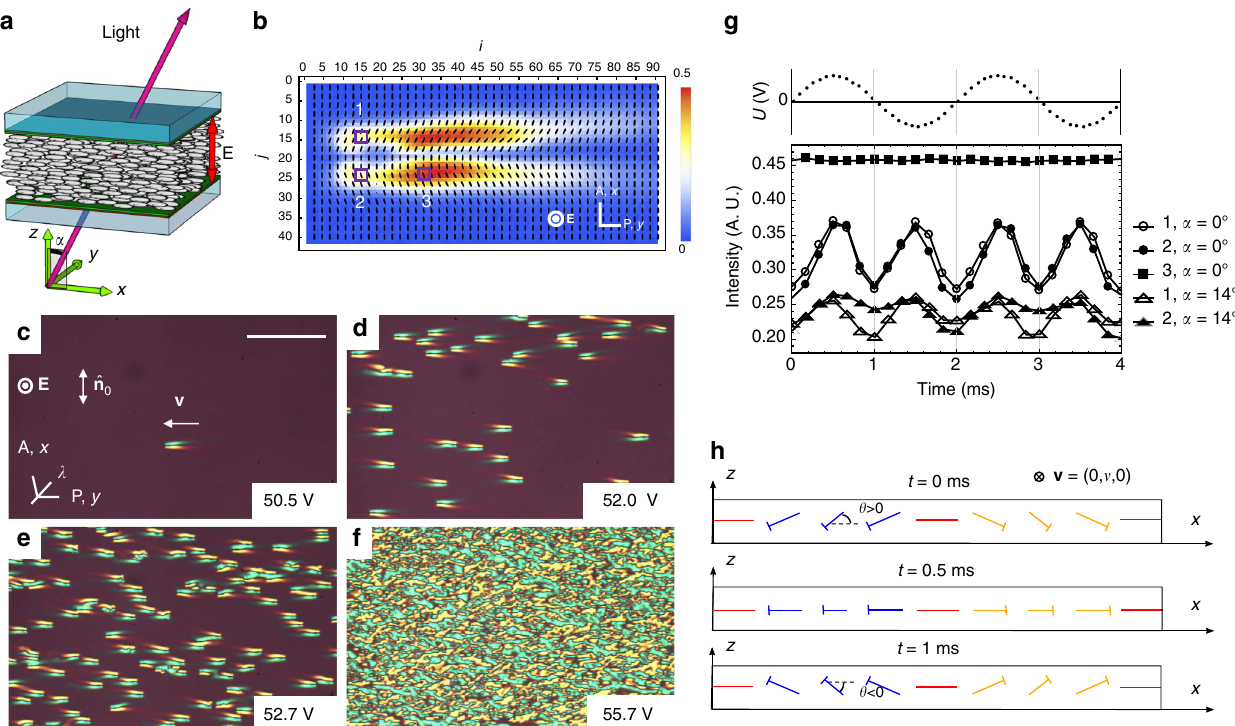
Fig. 1 Director bullets in a planar nematic cell. a Cell scheme. b Transmitted light intensity map and director distortions in the xy plane within a single bullet ( U = 65.4 V, f = 500 Hz, T = 40 °C, d = 8.0 μ m). The bar shows a linear scale of transmitted light intensity; the pixels are labeled by ( i , j ) coordinates. The length of a single step, i → i ± 1 or j → j ± 1, is 1 μ m. c – e Director bullets are observed between crossed polarizers and a compensator with the optic axis λ as the voltage U increases as indicated ( f = 450 Hz, T = 45 °C, d = 7.5 μ m). Scale bar 200 μ m. f Irregular stripe domains formed under a high applied voltage U = 55.7 V. g Dynamics of the transmitted light intensity for the same parameters as in b , at locations 1, 2, and 3 indicated in b for normal, α = 0 and oblique, α = 14° incidence of light; α is measured in the xz plane. h Schematic 3D director fi eld at the head of the bullet for three instants separated by a quarter period of the applied voltage. The nails represent a tilted director, with the heads closer to the observer than the